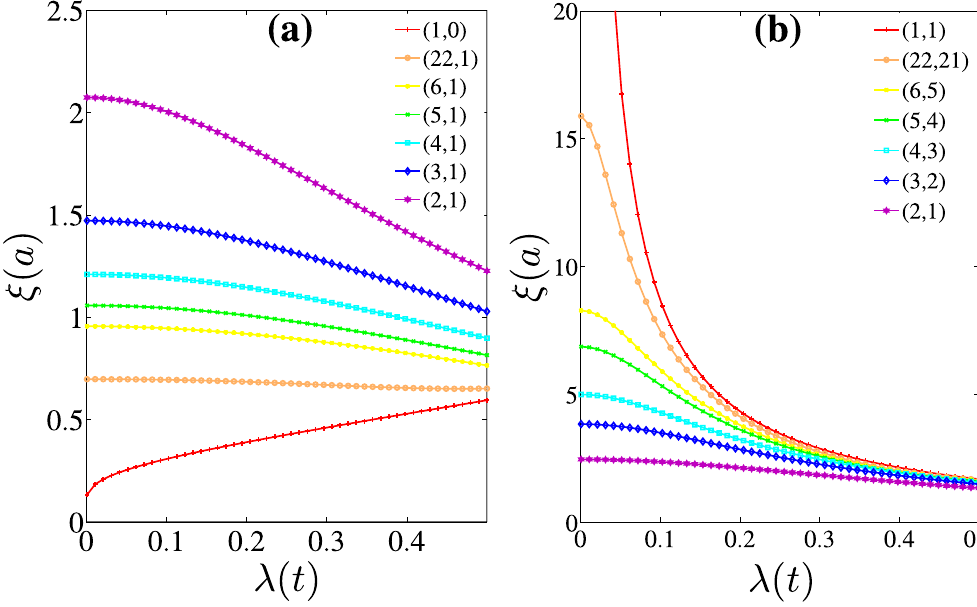
Figure 2. Penetration depths of QSH edge states as functions of the strength of SOC for ( a ) zigzag-like chiral edges with indices ( n + 1,1) and ( b ) armchair-like chiral edges with indices ( n + 1, n ). The results of perfect zigzag edge (1,0) and armchair edge (1,1) are also included as a reference. The Fermi energy is set to E F =